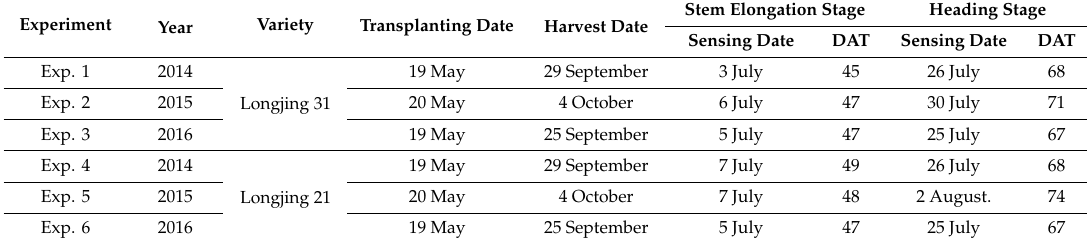
Table 1. The details about the crop growth and crop sensing within the experiments performed in this